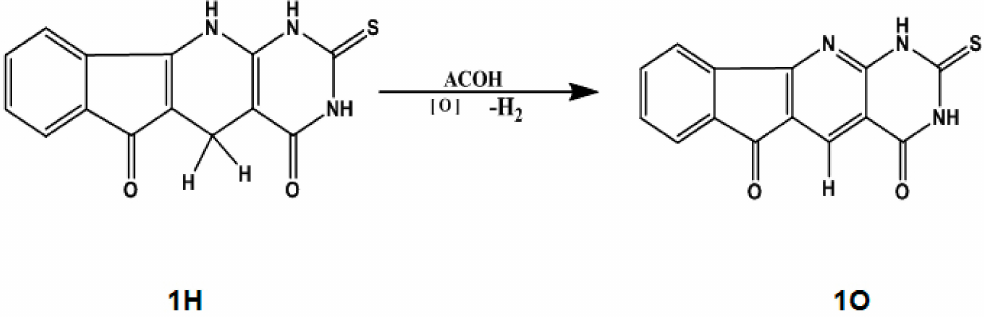
Figure 1. The oxidation of 1H form of TUDHIPP to